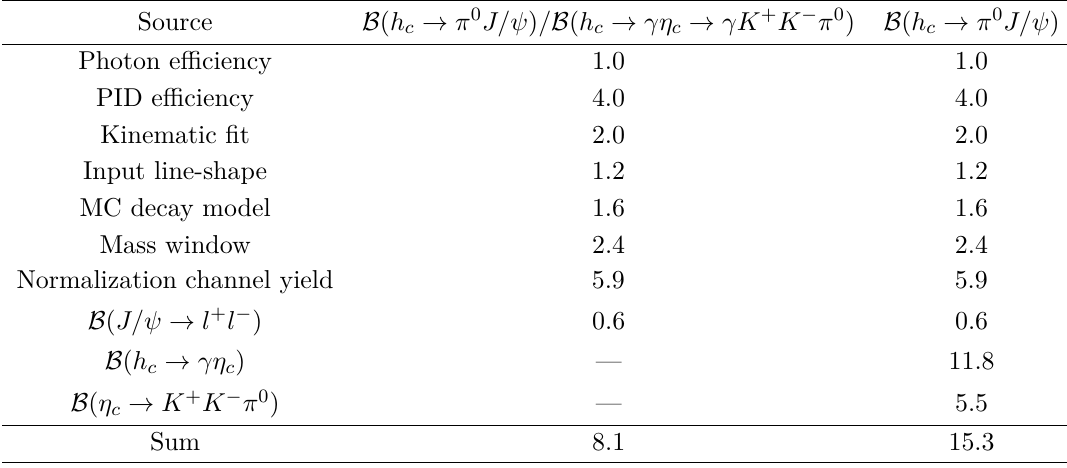
Table 2 . Relative systematic uncertainties (in % ) on the branching ratio B ( h c → π 0 J/ψ ) / B ( h c → γη c → γK + K − π 0 ) and the branching fraction B ( h c → π 0 J/ψ ) . Dashes are used when sources of uncertainty are not